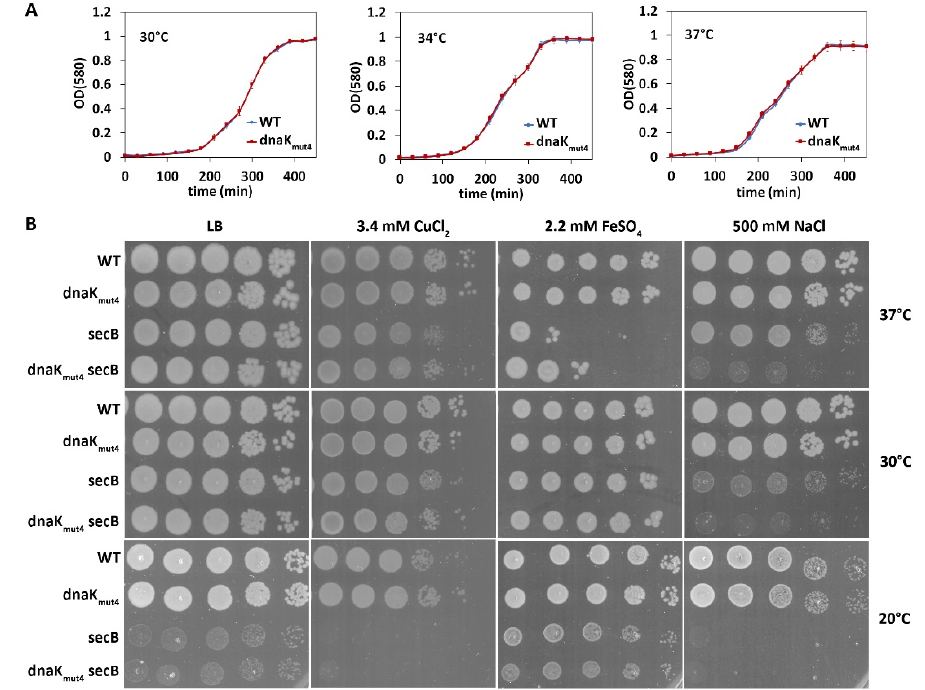
Figure 5. Mutation of the C -terminal conserved motif of DnaK results in no growth or heat tolerance defect in wild-type background, but affects the stress tolerance of secB deficient strain. ( A ) Growth curves of P. putida wild-type (WT) and dnaK mut4 strains in LB medium at 30 °C, 34 °C and 37 °C. The strains were grown on microtiter plates. The results are the average of at least 15 replicates and error bars represent the standard deviation. ( B ) Solid medium stress tolerance assays of P. putida wild-type and dnaK mut4 strains and their secB deficient derivatives. Tenfold serial dilutions of the overnight cultures were spotted onto LB medium and on LB supplemented with NaCl or metal salts. Final concentrations of the chemicals are indicated. Plates were incubated at indicated temperature for 24 h (LB and LB + 3.4 mM CuCl 2 at 37 °C and 30 °C) or 48 h.